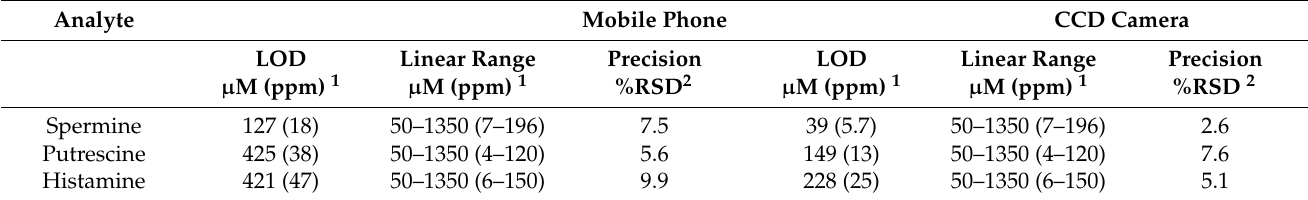
Table 1. Mobile Phone and CCD Limits of Detection, Linear Range and Precision for Biogenic Amine ECL. Analyte Mobile Phone CCD